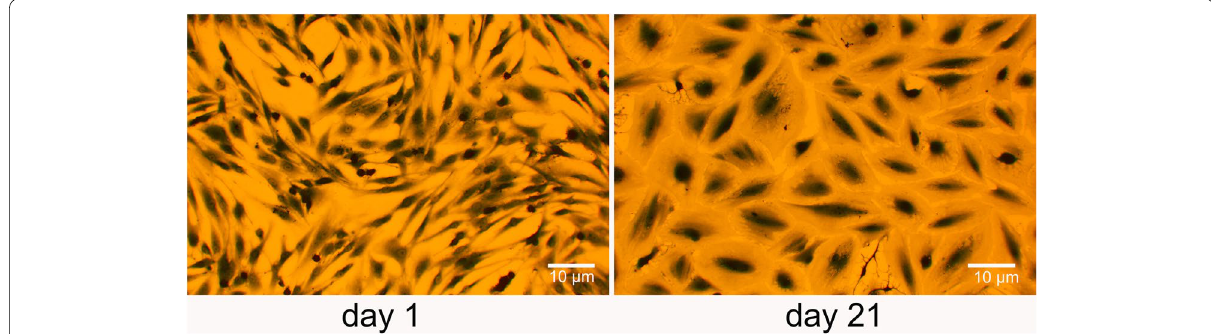
Fig. 1 Phenotypic alterations of human primary osteoblasts during 21 day in vitro